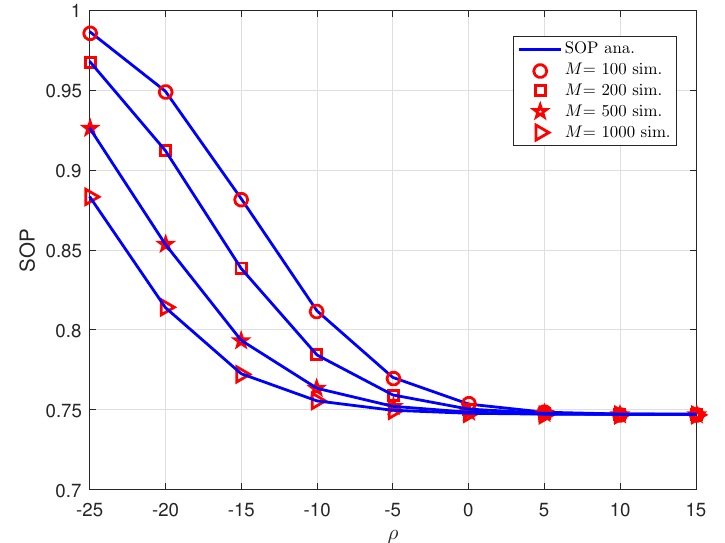
Figure 9. SOP versus ρ for different M